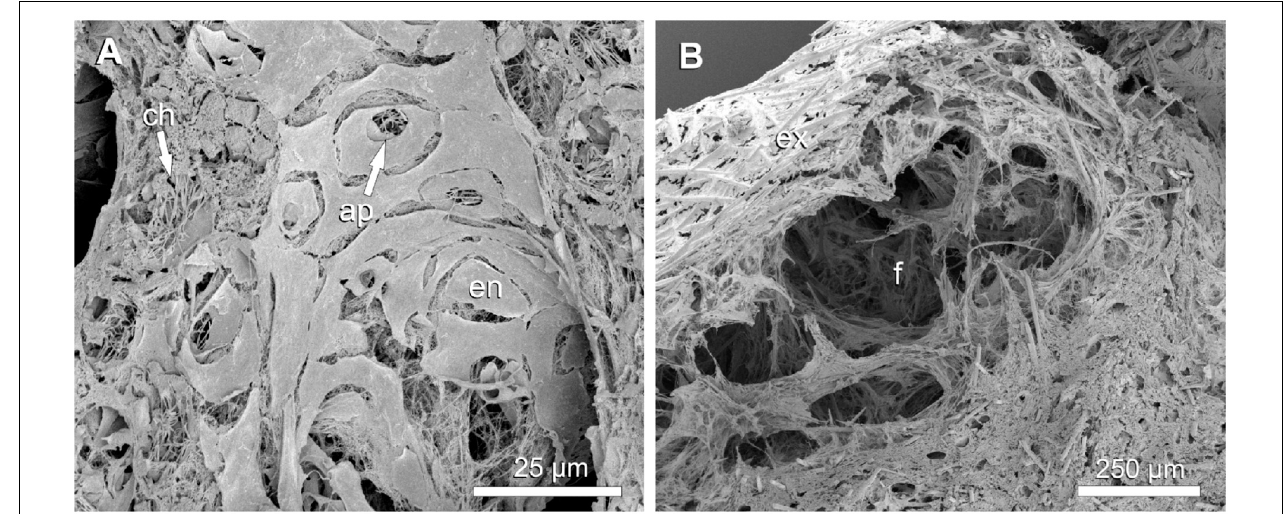
FIGURE 7 | Halichondria panicea , SEM, cryofracture. Internal morphology of a contracted (after exposure to 1 mM GABA) single-osculum explant. (A) Excurrent canal with constricted apopyles and choanocyte flagella protruding into the canal. (B) Cavity with stretched fibers between choanosome and exopinacoderm. Legend: ap: apopyle, ch: choanocyte chamber, en: endopinacocyte, ex: exopinacoderm, f: fibers.